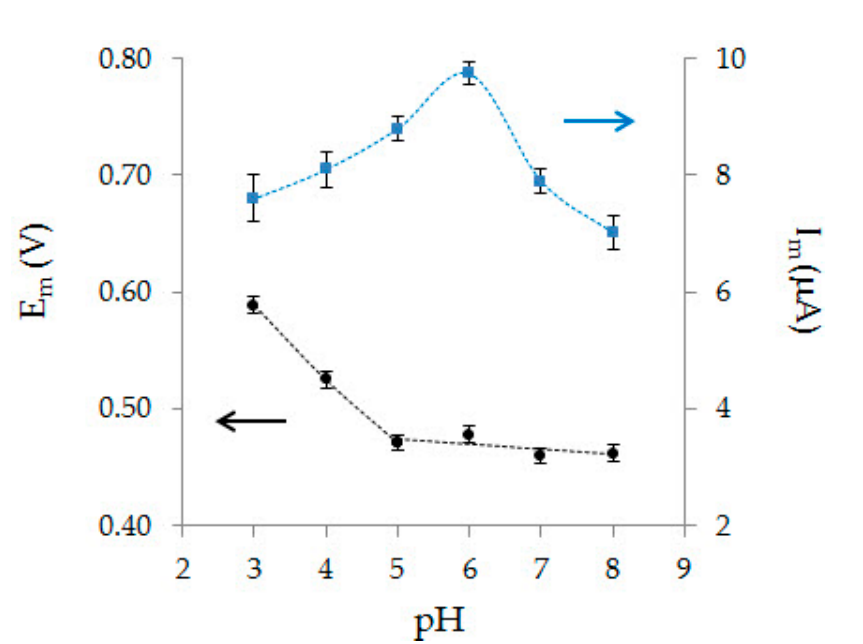
Figure 6. Effect of background electrolyte pH on AA oxidation peak current ( I m ) and peak potential ( E m ) (0.1 mM) on Au-gr/CVE.